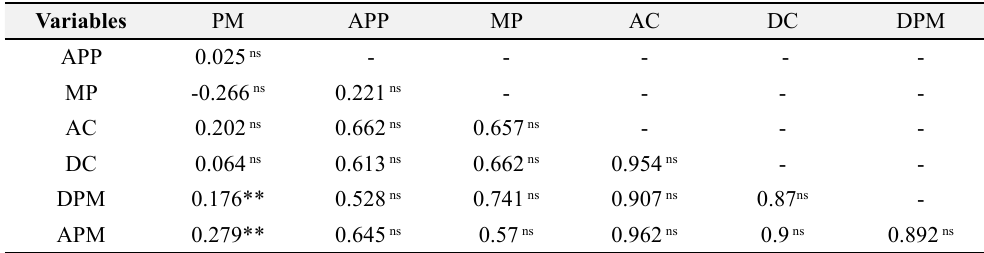
Table 3 - Correlation of production and biometric variables of colonies of four species of stingless bees in the municipality of Miracema-TO,